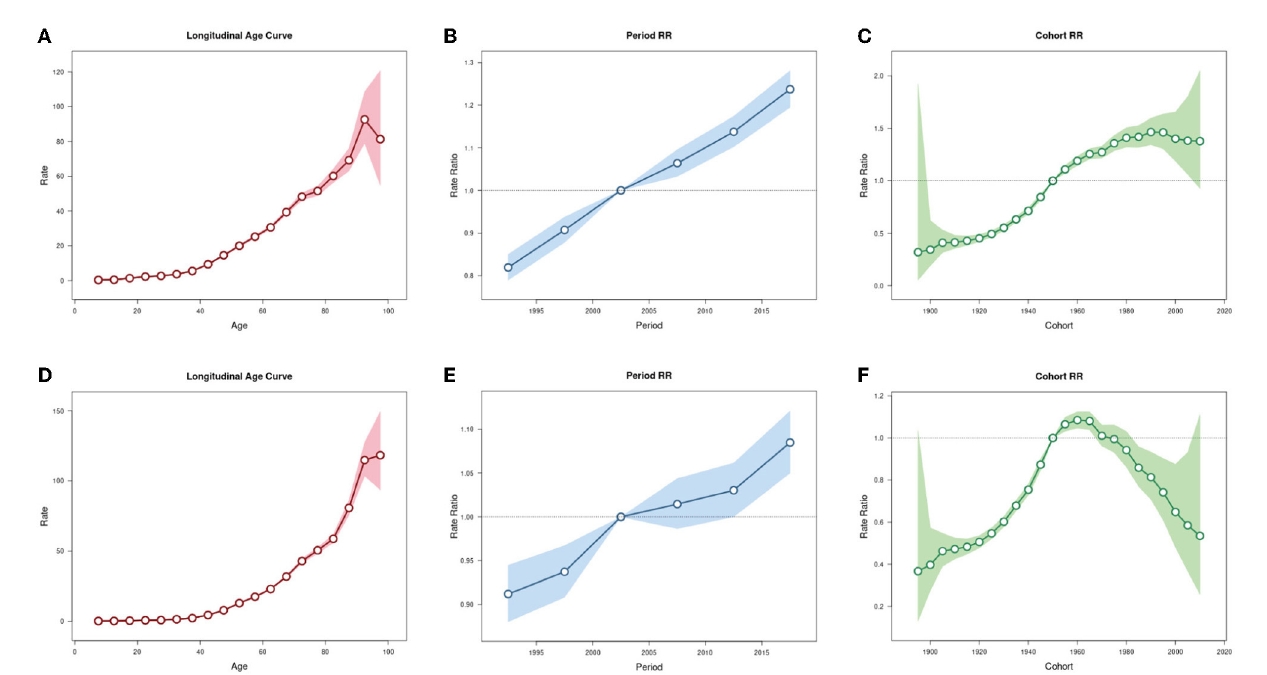
FIGURE5 Age-period-cohort analysis for incidence and mortality rates of ovarian cancer in China. (A) Age effect for incidence rate. (B) Period effect for incidence rate. (C) Cohort effect for incidence rate. (D) Age effect for mortality rate. (E) Period effect for mortality rate. (F) Cohort effect for mortality rate.